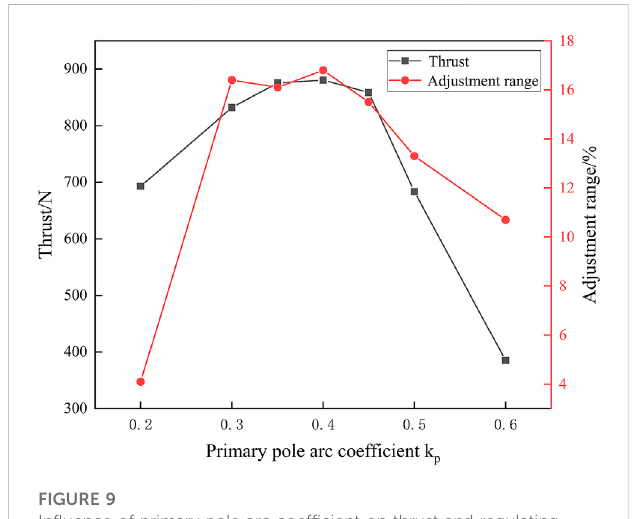
FIGURE 10 In fl uence of armature current advance angle on thrust.